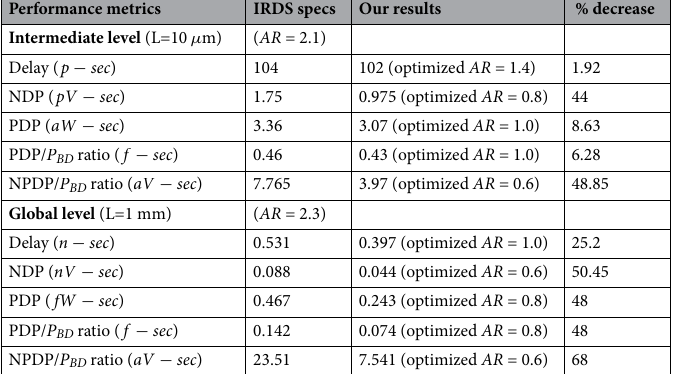
Table 4. Comparison of our results (considering FeCl 3 doped MLGNR interconnect) with IRDS 2018 Roadmap suggestion of Aspect Ratio (for copper interconnect) 1 at 7 nm technology node.